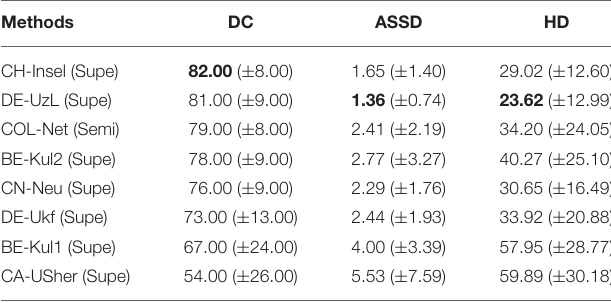
TABLE 2 | The results of the participants on the SPES dataset. Methods